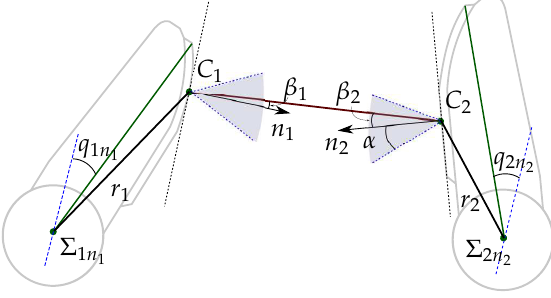
Figure 5. Fingertips and angles used to compute the friction